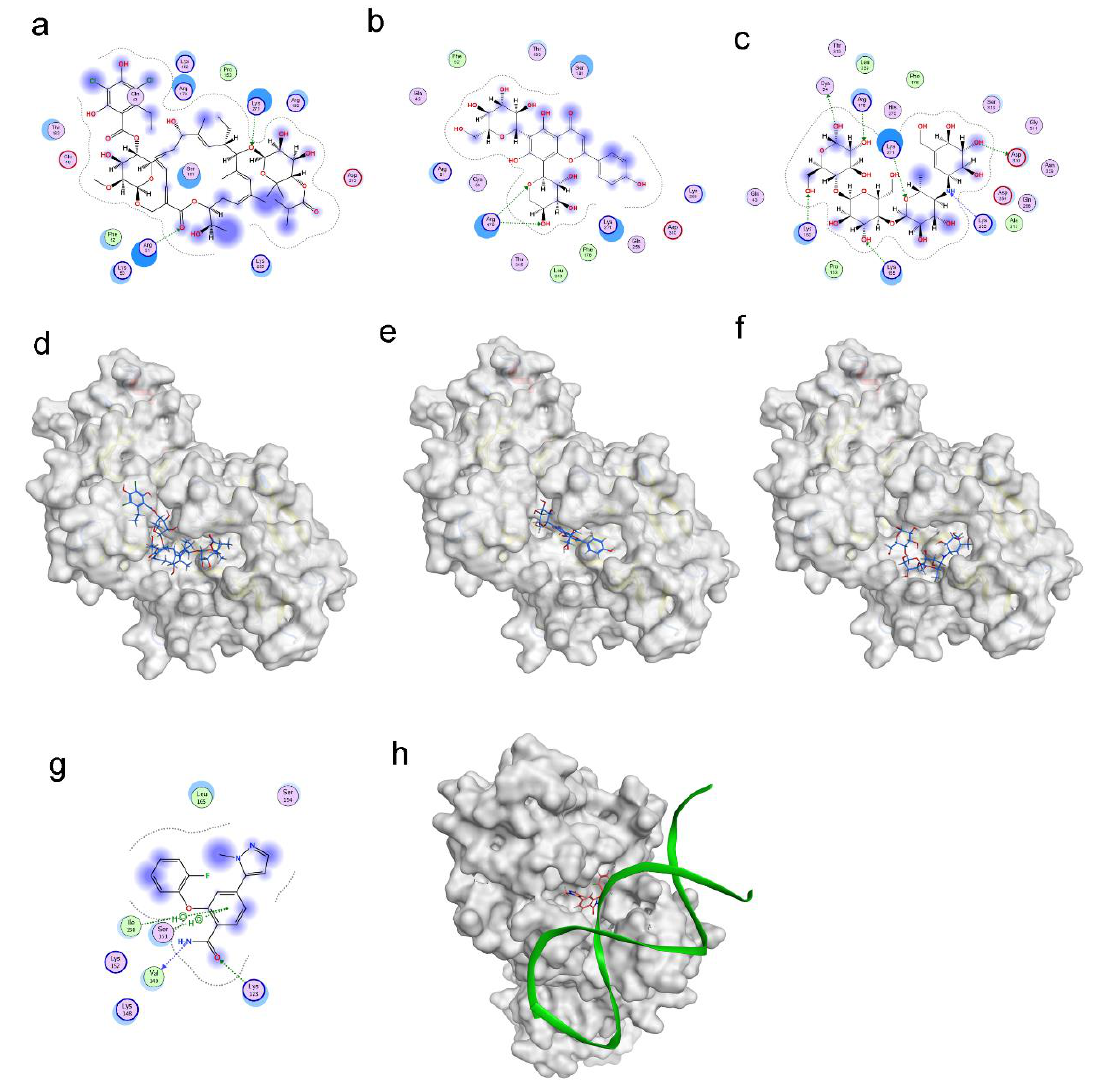
Figure 1. Molecular docking revealed binding modes of three hits and positive control with RBPJ protein by using MOE. Two-dimensional and three-dimensional docking poses of fidaxomicin ( a , d ), schaftoside ( b , e ), acarbose ( c , f ), and positive control RIN1 ( g , h ) at active sites of RBPJ were repre- sented, respectively, showing the shape complementarity and the H-bonding with key contributing amino acids of RBPJ.